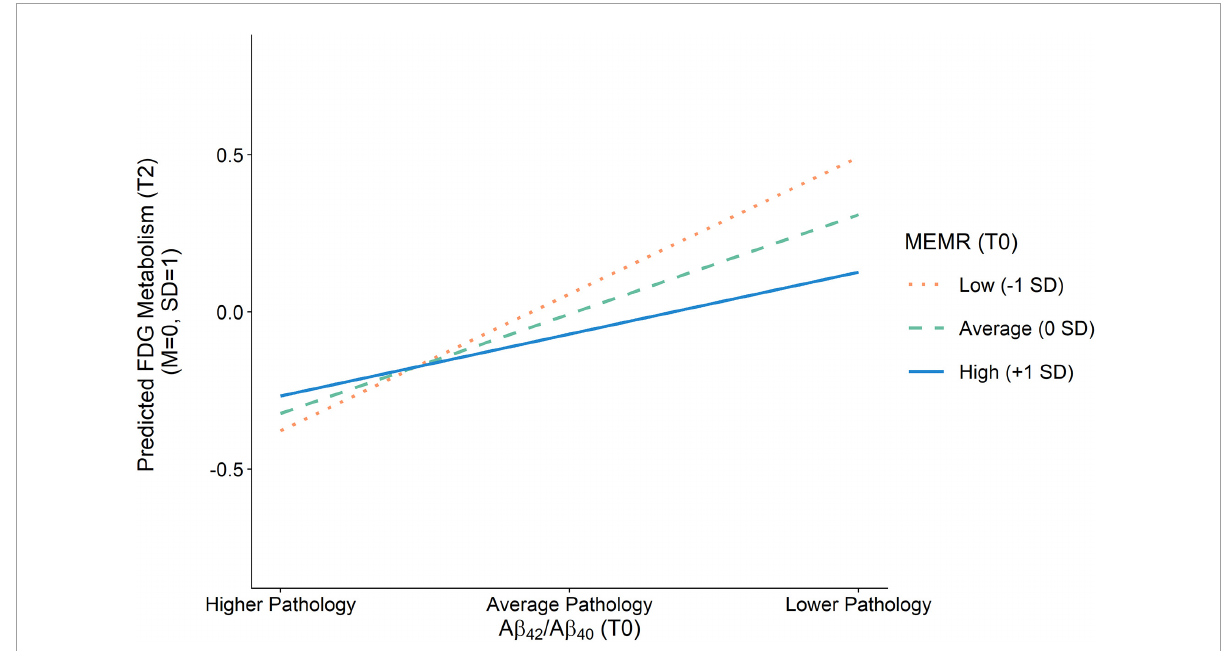
FIGURE4 Effect of amyloid pathology on FDG metabolism as a function of the residual reserve index. Amyloid pathology (A β 42 /A β 40 ) was modeled as a continuous variable and is separated into higher pathology (–1 SD), average pathology (0 SD), and lower pathology (+1 SD) for illustration purposes. A β 42 /A β 40 , ratio of CSF β -amyloid 1 - 42 to β -amyloid 1 - 40 ; FDG, uptake of 18 F fluorodeoxyglucose tracer in AD-specific regions of interest; MEMR, the residual reserve